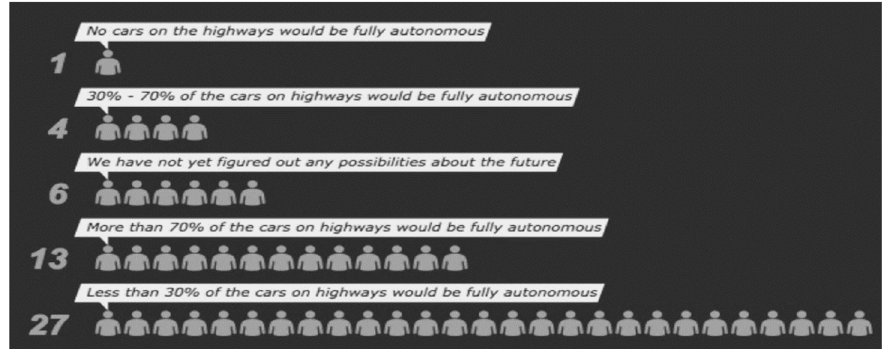
Figure 3. Autonomous Vehicle scenarios until 2030.